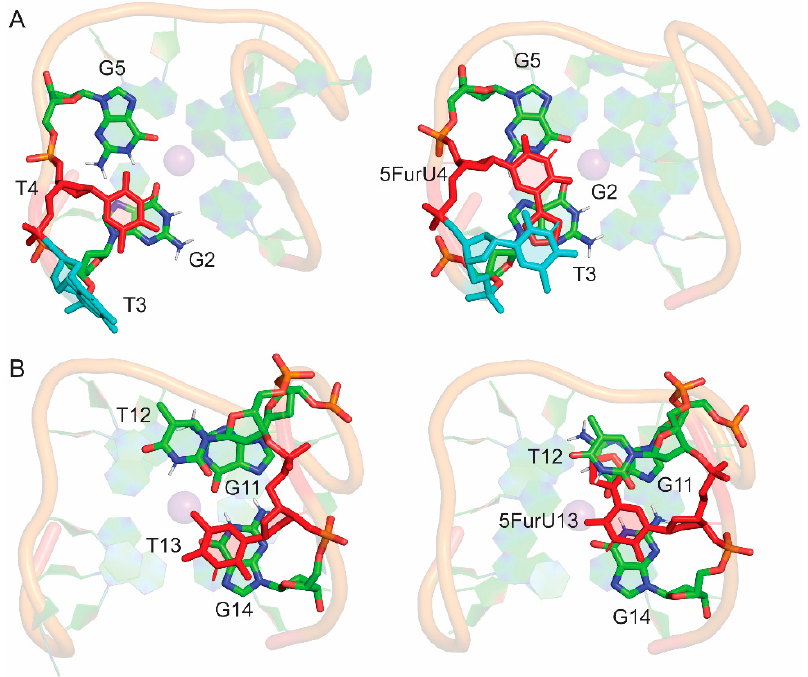
Figure 4. ( A ) Stacking interactions of the T4 base in the native (left) and modified (right) TBA. ( B ) Stacking interactions of the T13 base in the native (left) and modified (right) TBA.